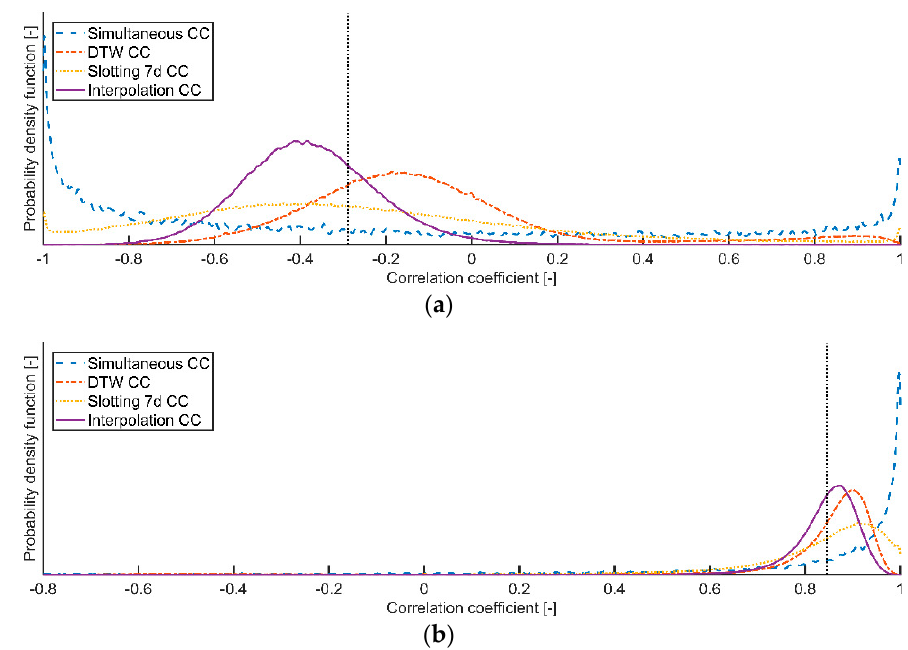
Figure 3. Observed distribution of estimated CCs for the three methods: the proposed method based on interpolation (plain purple line), the method based on the simultaneous observations only (dashed blue line), dynamic time warping (DTW) with a Sakoe–Chiba band of 45 days (dotted-dashed red line), and the slotting method with a bin size of ±7 days (dotted yellow line). The vertical dotted line represents the true CC. ( a ) The small negative correlation and ( b ) the strong positive correlation. Table 1. Descriptive statistics of the CC estimators for the simultaneous observations, the slotting method with three different bin sizes, DTW with a Sakoe–Chiba band of 45 days, and the interpolation method and for both examples.